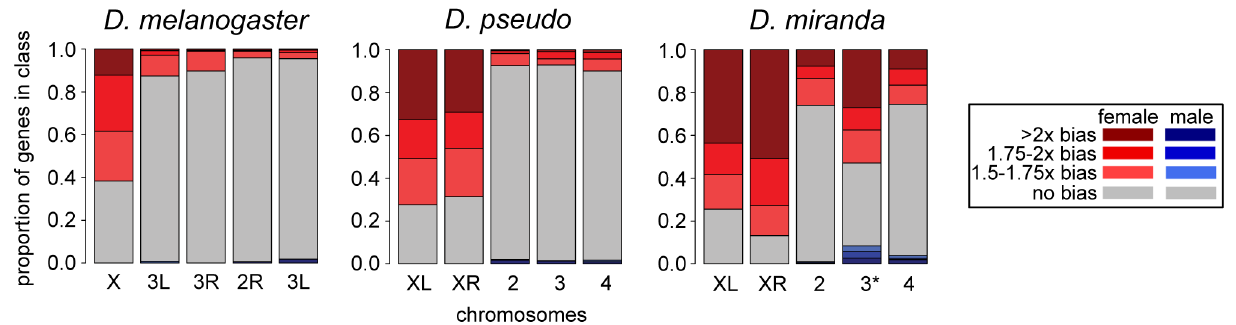
Figure 4. Sex-bias of transcripts in embryo at one timepoint across three species. Comparison of sex bias in transcripts for zygotically transcribed genes (using the allele-specific zygotic definition) in D. pseudoobscura , D. miranda , and D. melanogaster , at one stage (late stage 5, or the end of blastoderm) early on in development, before the activation of MSL-mediated dosage compensation. Chromosomes are in the same order for all species, D. melanogaster has only the ancestral X, D. pseudoobscura and D. miranda both have XL and XR, and D. miranda additionally has the neo- XY chromosome (indicated with 3*). The neo-XY levels shown include those from both the neo-X and the neo-Y in males, and as many of these genes on the neo-Y are still producing transcript in males, this chromosome appears to have less female bias than the ancestral X